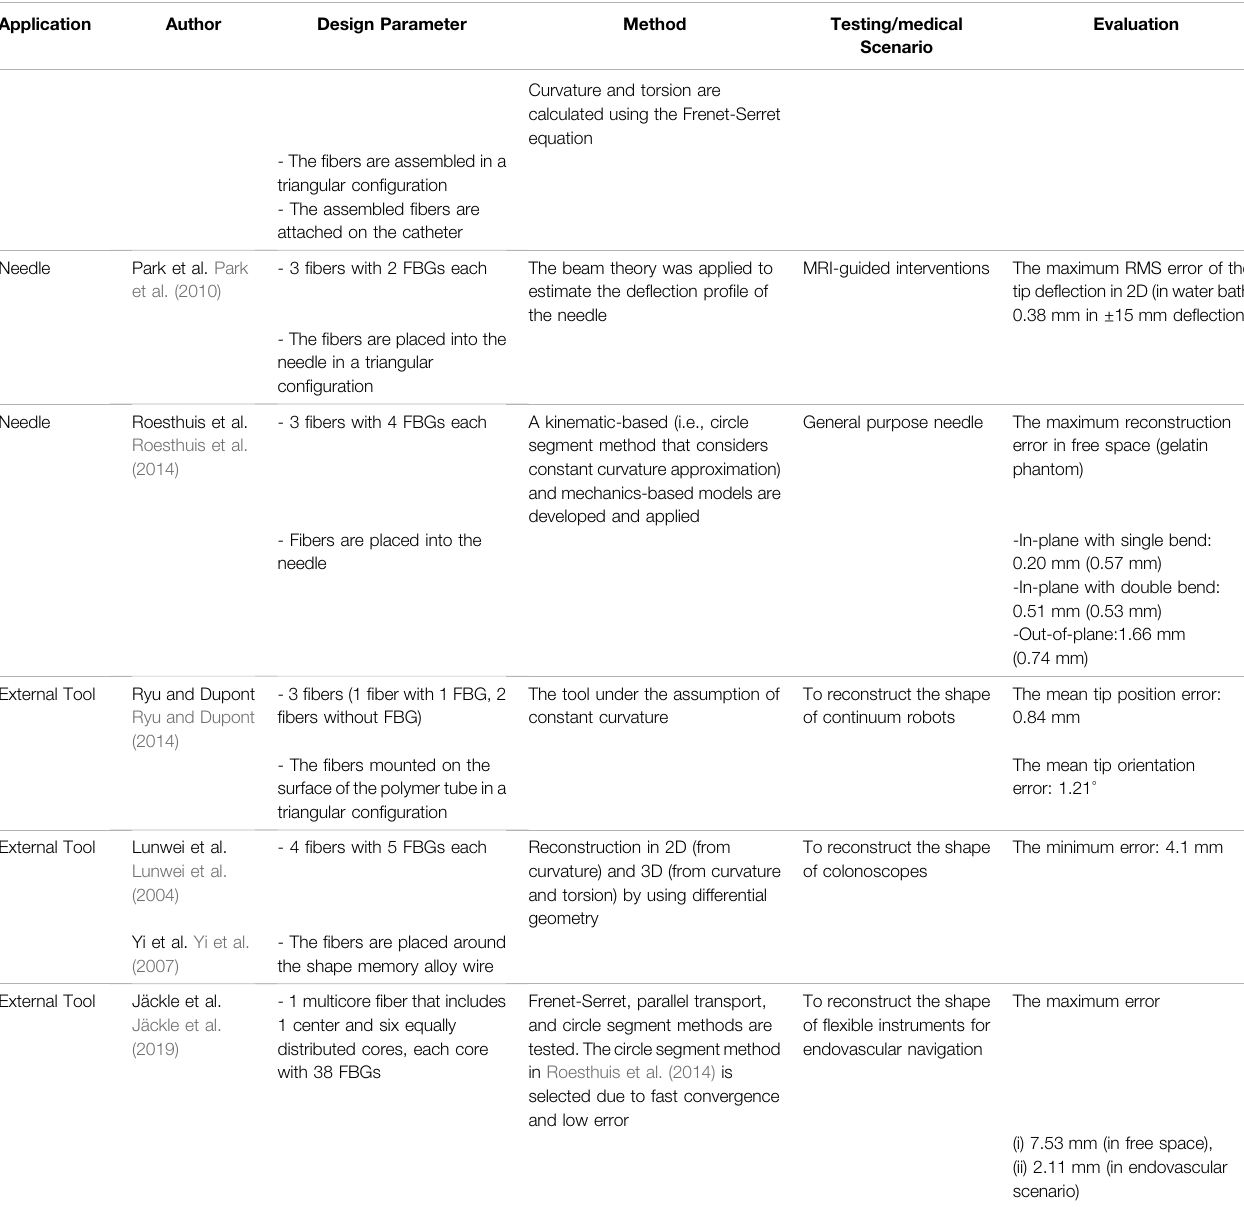
TABLE 1 | ( Continued ) Summary of FBG based Shape Reconstruction